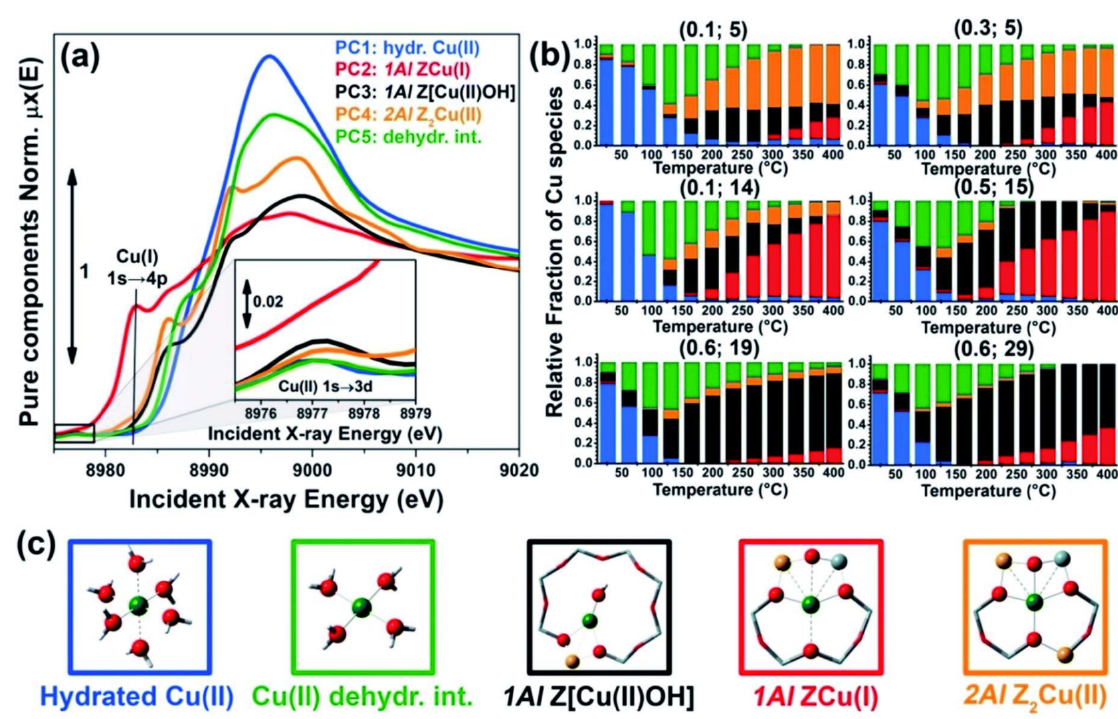
Figure 4. Multivariate curve resolution (MCR) coupled with the alternating least square (ALS) analysis of global temperature-dependent XANES dataset collected for six Cu-CHA samples with different compositions during He-activation from 25 to 400 ◦ C, assuming the presence of 5 pure components. ( a ) XANES spectra of pure components µ i (E) derived from MCR-ALS. The inset reports a magnification of the Cu(II) 1s → 3d transition region in the theoretical spectra; ( b ) Temperature-dependent abundance of pure species, w ip (Cu/Al; Si/Al, T), in each of the catalysts (bars have the same colors as the corresponding spectra in panel ( a )); ( c ) Proposed assignment of the five pure components (PC) to specific Cu-species/sites formed in the Cu-CHA catalyst as a function of composition and activation temperature, using the same color code as in parts ( a ) and ( b ); Blue (PC1): mobile Cu(II)-aquo-complexes [Cu(II)(H 2 O) n ] 2+ /[Cu(II)(H 2 O) n − 1 (OH)] + with n = 6; green (PC5): Cu(II) dehydration intermediate, possibly represented by mobile [Cu(II)(H 2 O) n ] 2+ /[Cu(II)(H 2 O) n-1 (OH)] + complexes with n = 4; black (PC3): 1Al Z[Cu(II)-OH] sites in their oxidized form; red (PC2): 1Al Z-Cu(I) sites in their reduced form, resulting from self-reduction of 1Al Z[Cu(II)OH] species; orange (PC4): 2Al Z2-Cu(II) sites. Atom color code: Cu: green; H: white; O: red; Si: grey; Al: yellow. Chem. Sci. , 2017